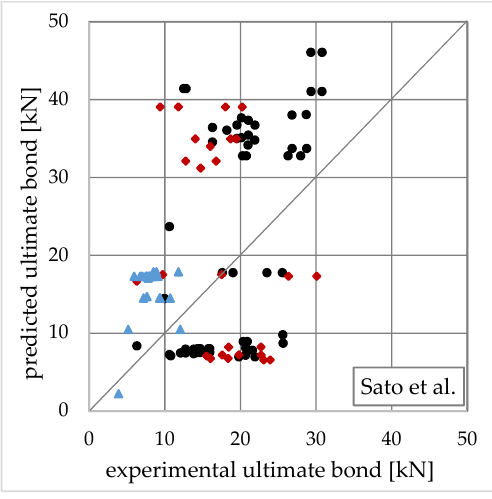
Figure 15. Test vs. predicted bond force using the Sato et al. model [27].